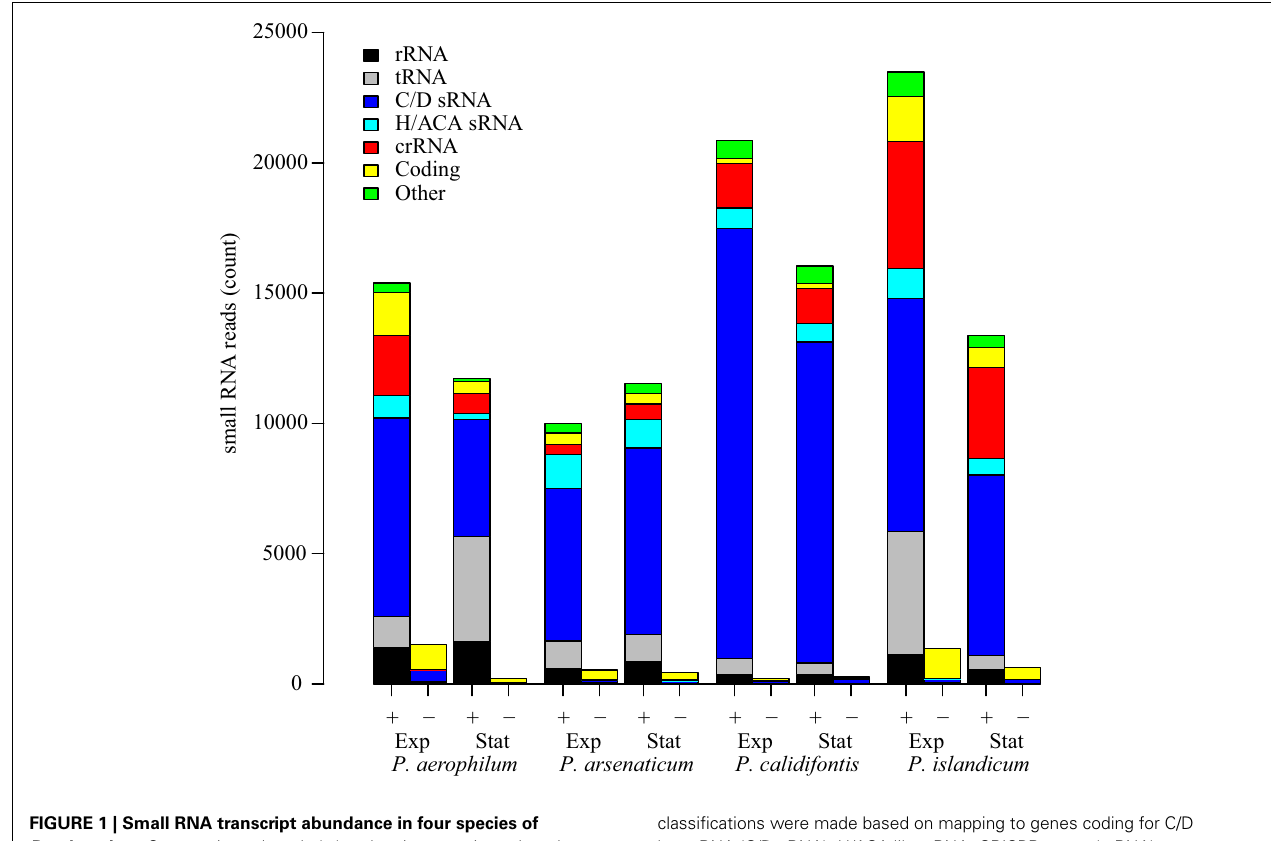
FIGURE 1 | Small RNA transcript abundance in four species of Pyrobaculum . Sense oriented reads ( + ) and antisense-oriented reads ( − ) shown in barplots for each species. Samples of each species were taken at both exponential (Exp) and stationary phases (Stat). RNA